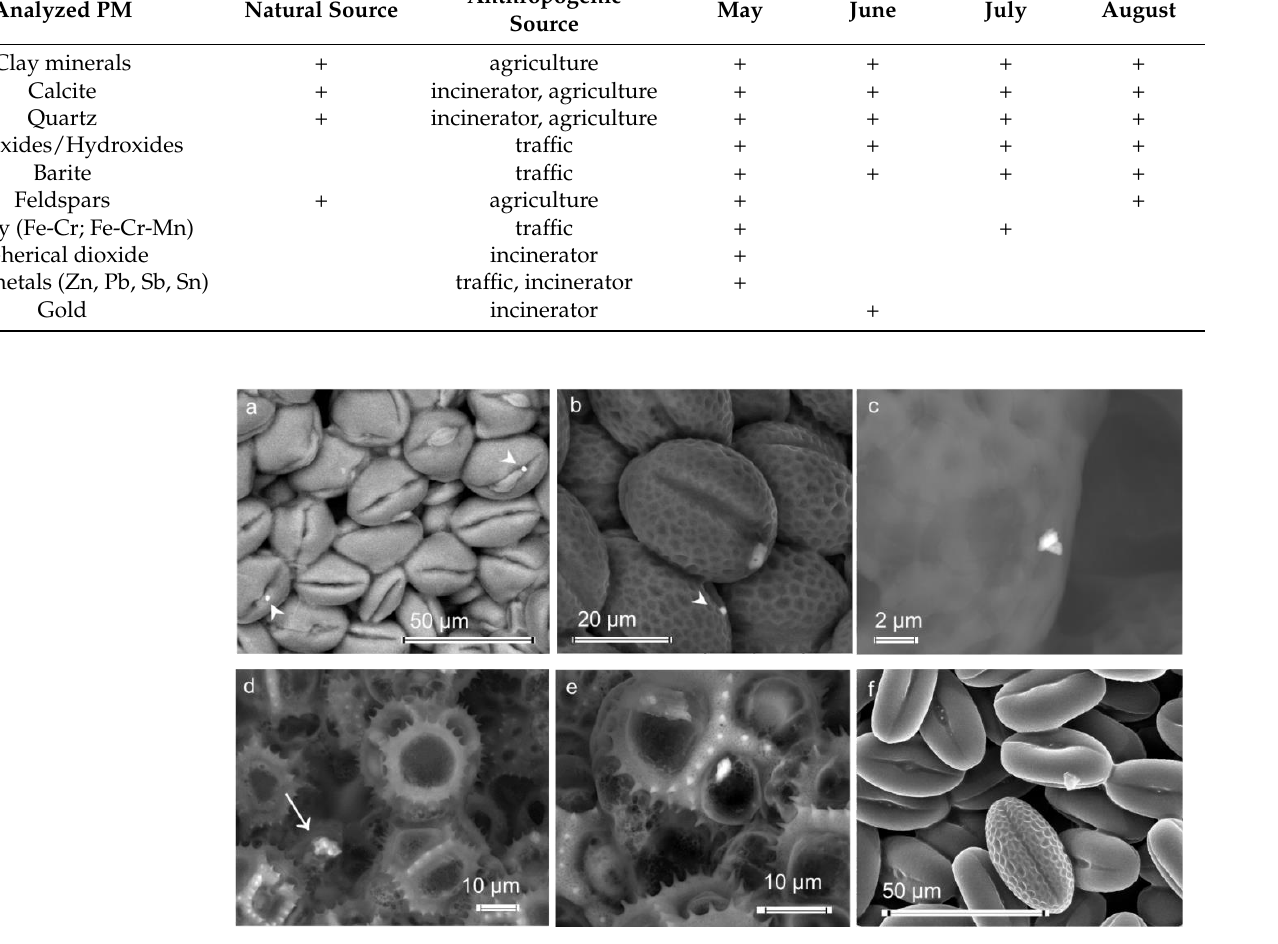
Figure 3. Airborne PM collected on all pollen grains. ( a ) Two particles composed of iron ox- ides/hydroxides (arrowheads; 1.5 and 1.4 µ m) on alfalfa pollen. ( b ) A particle composed of iron oxides/hydroxides (arrowhead; 1.5 µ m) on pollen of a Brassicacea. ( c ) PM of barite (1.2 µ m). ( d ) A particle of quartz (10 µ m) on pollen grains of Taraxacum officinale . ( e ) PM of a clay min- eral (6.9 µ m) on a pollen grain of T. officinale . ( f ) Pollen grains of Medicago sativa and a Brassi- cacea contaminated by PM of calcite (4.7 µ m). Corresponding EDX spectra are provided in the Supplementary